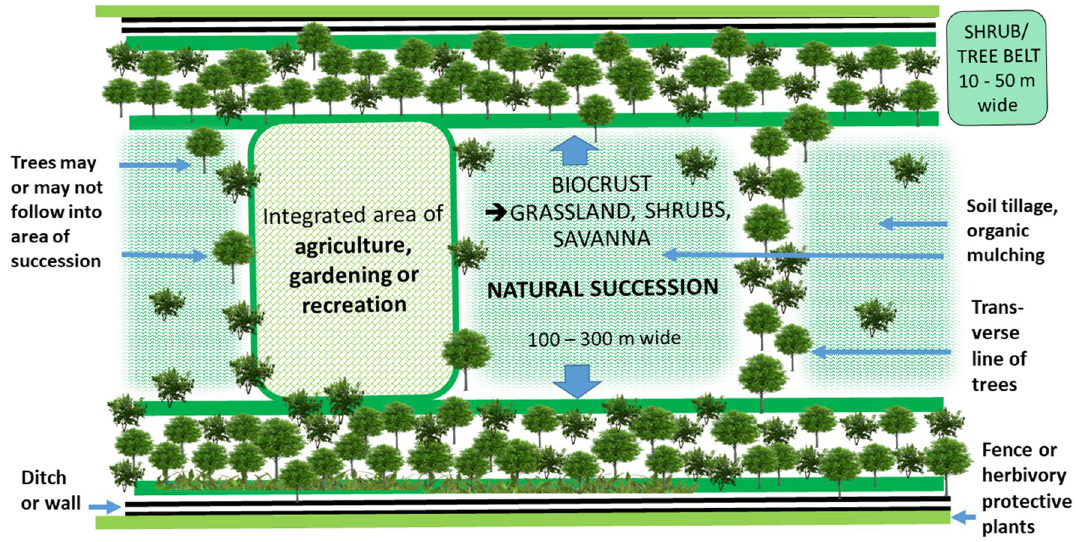
bined: Protection from wind (windbreak) and dust, increase in relative humidity, tillage and amendment of soil, inoculation with